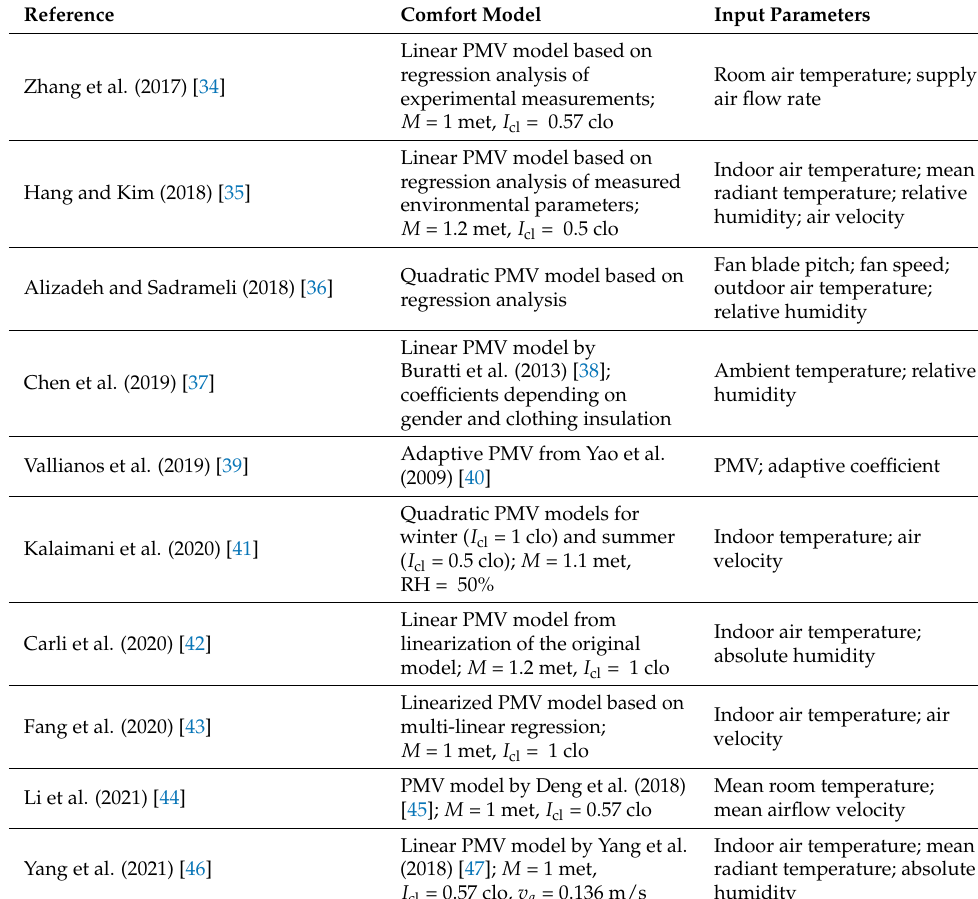
Table 4. Modified PMV